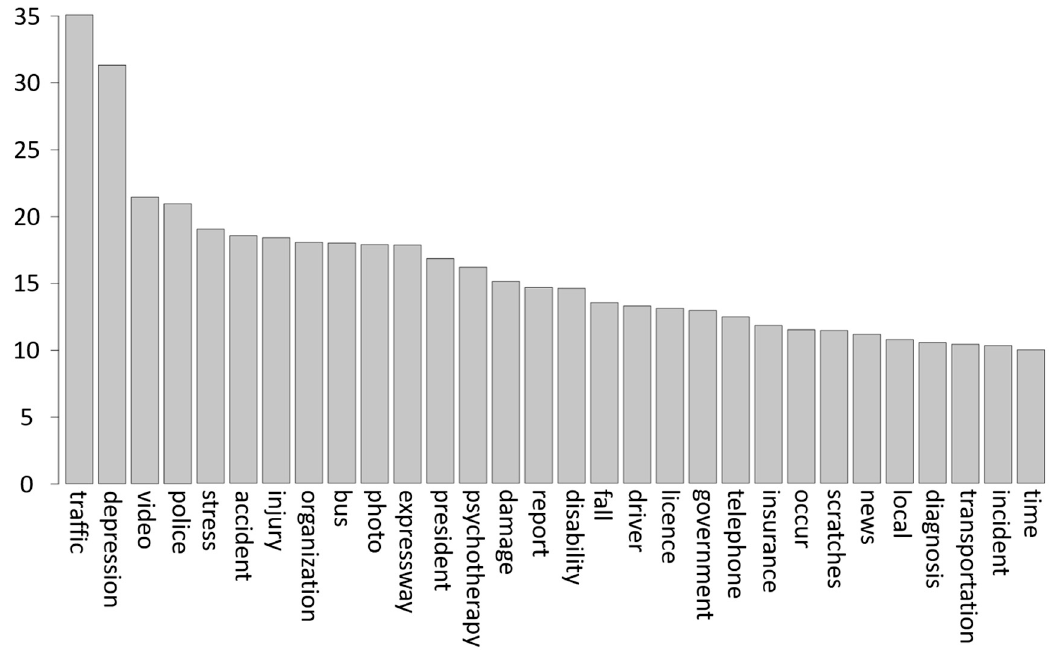
Figure 3. Weights of the words calculated with the use of TF-IDF in News Stream Data.